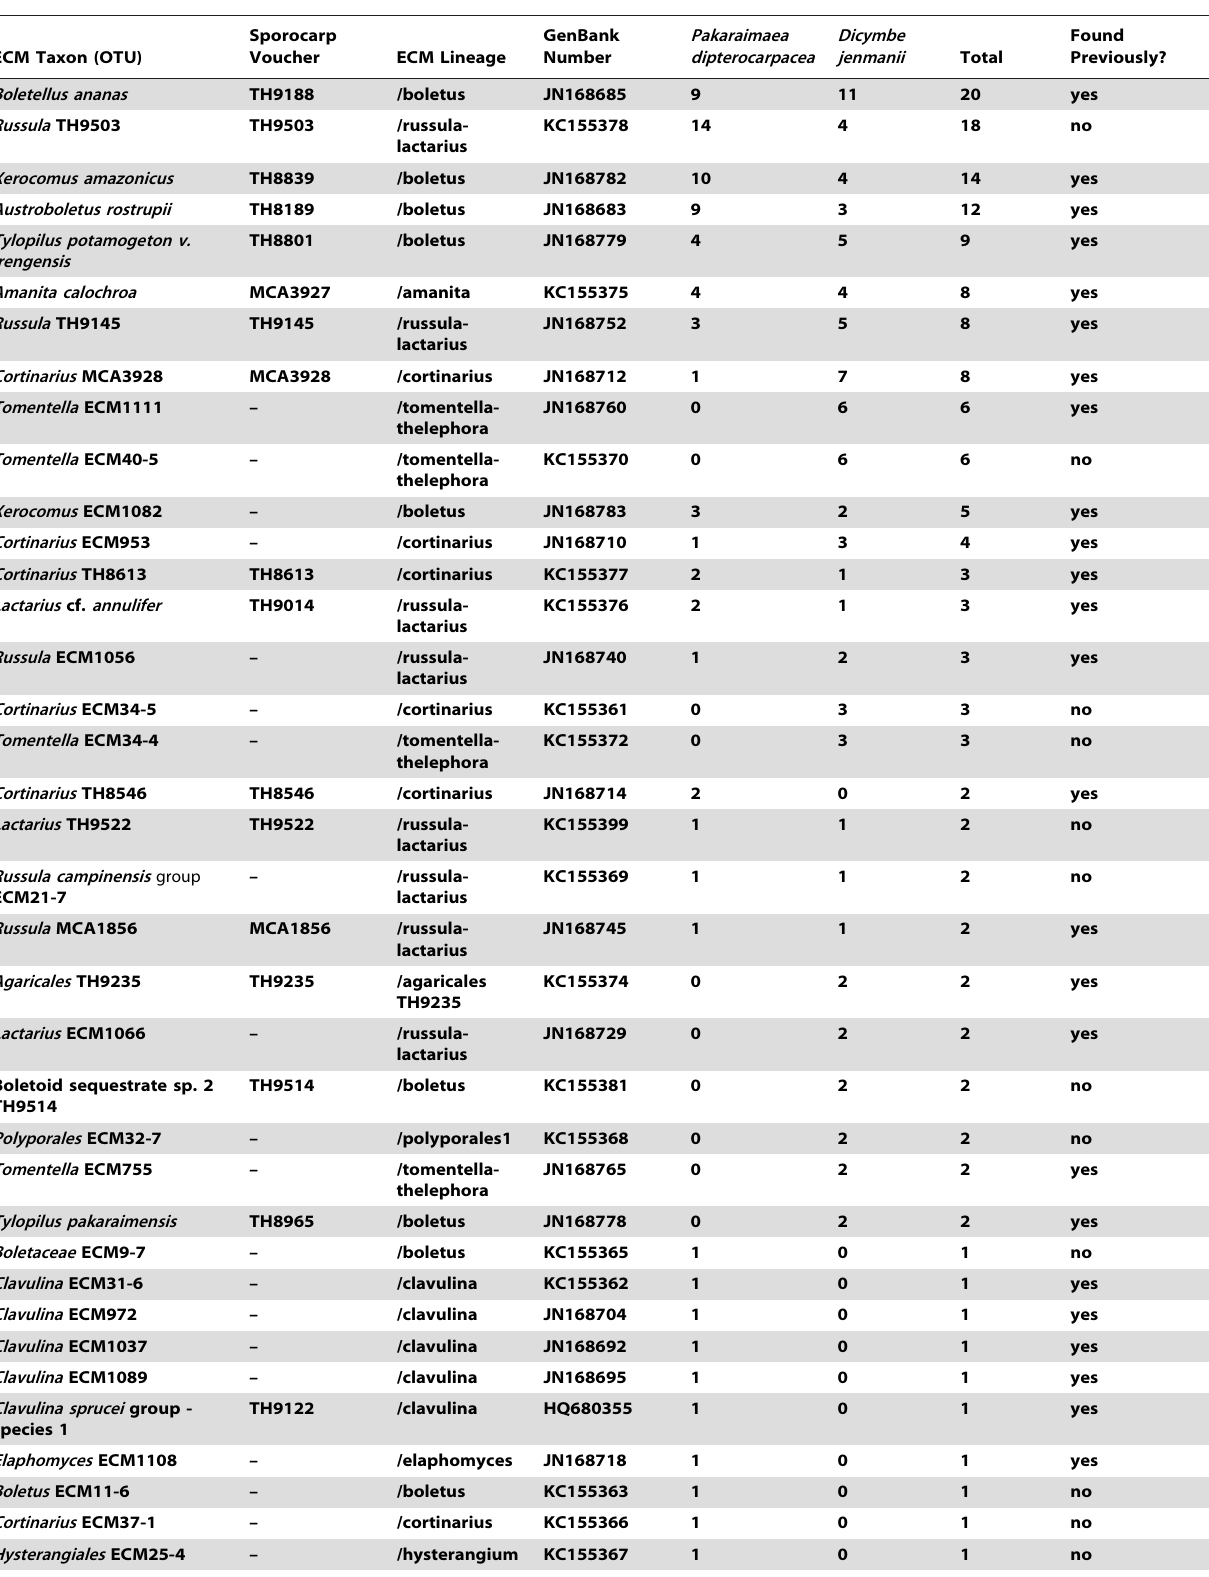
Table 1. Ectomycorrhizal fungi detected on the roots of Pakaraimaea dipterocarpacea and Dicymbe jenmanii in this study.